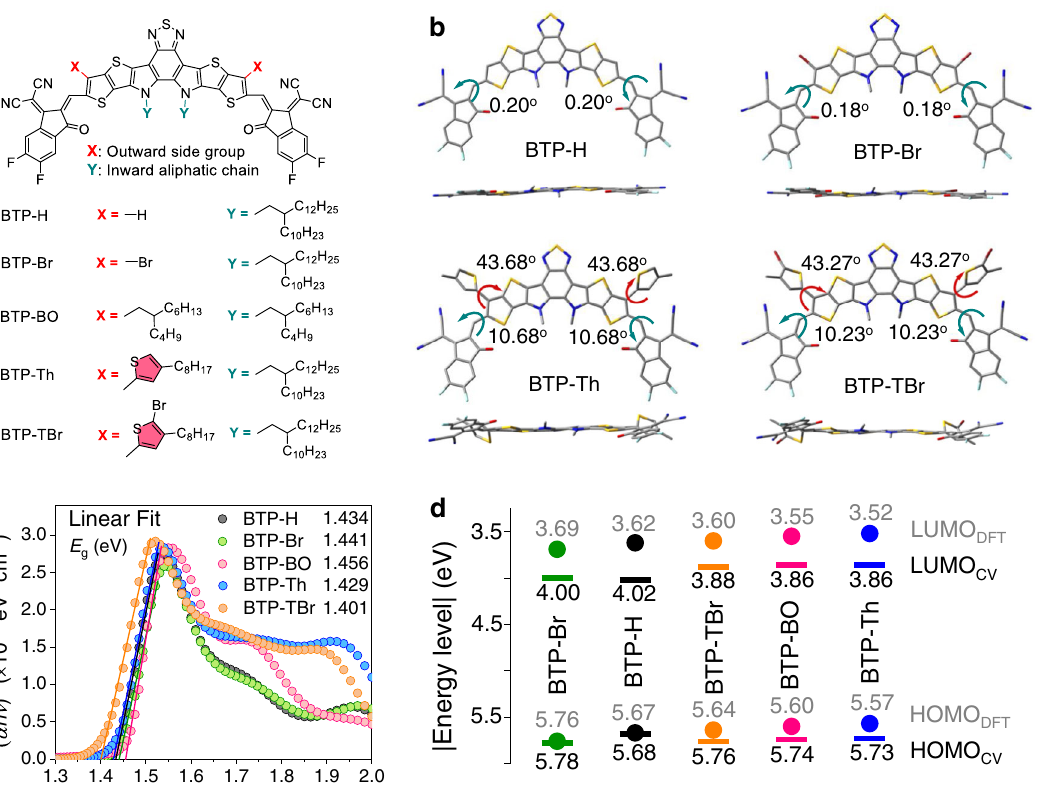
Fig.1|Molecularstructure/geometryandphotoelectricproperties.a Chemical structure of acceptors with varied side groups. b Optimized molecular geometry for acceptors calculated from DFT; the red and green arrows indicate the outward